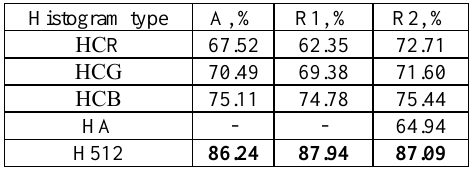
Table 2 . Comparative table of histogram’s